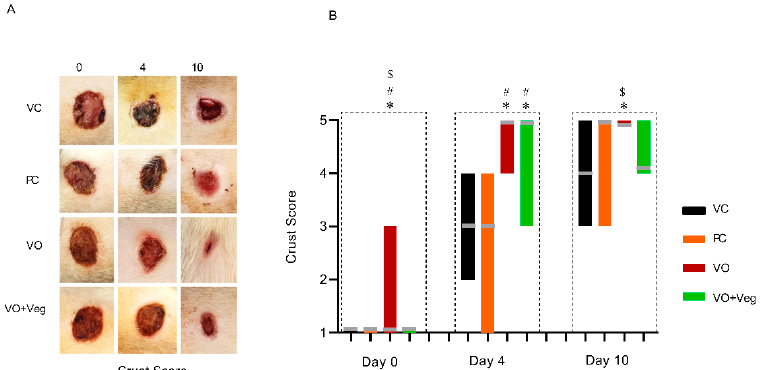
Figure 6. Representative images of crust in respective groups and treatment evaluation time ( A ). Graph of crust scores in VC, PC, VO, and VO + Veg groups, in three periods of evaluation. The bars represent the data dispersion (minimum and maximum), and the horizontal gray lines represent mode ( B ). * p < 0.05: VO vs. VC; # p < 0.05: VO vs. PC, and $ p < 0.05: VO vs. VO + Veg.